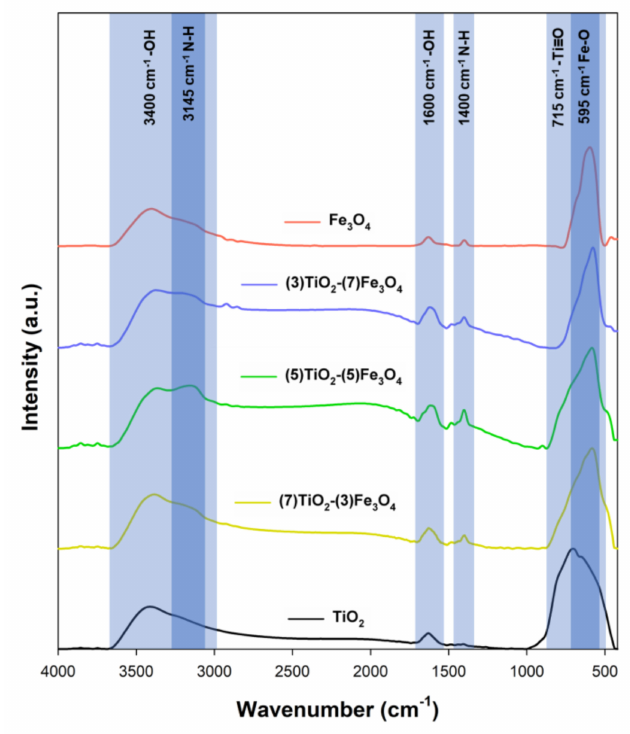
Figure 9. FTIR spectra for the TiO 2 , Fe 3 O 4 , and TiO 2 -Fe 3 O 4 materials.